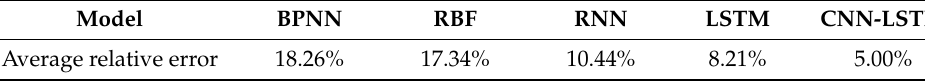
Table 4. The average relative error of five neural network models.